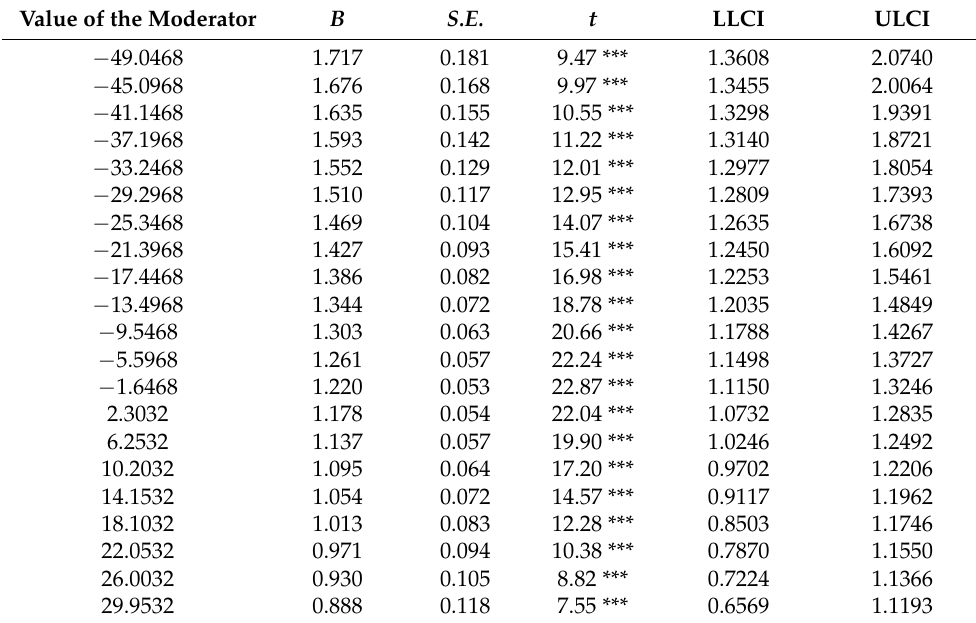
Table 4. Significant area in conditional effects of the focal predictor at values of the moderator (the emotionally adapted functions of